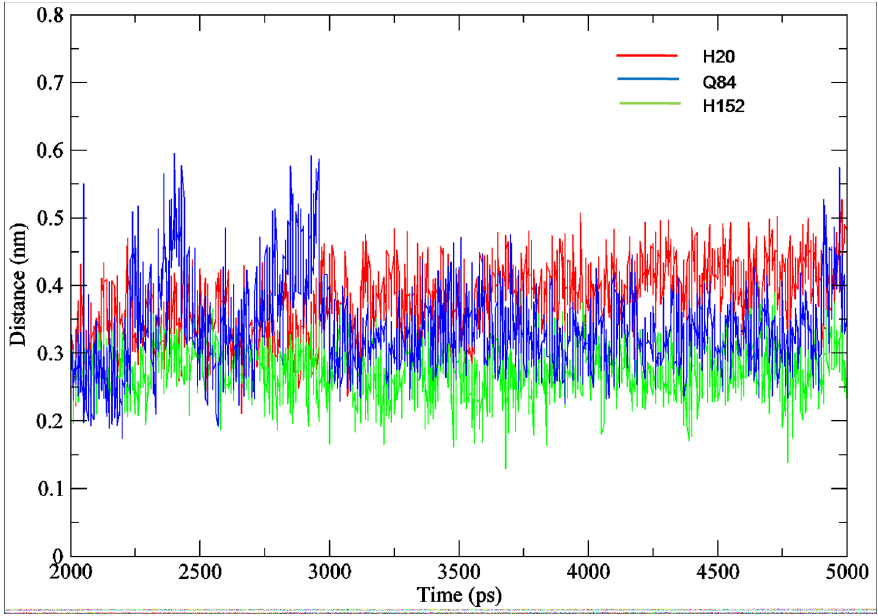
Figure 11. RMSF plot of F.ananassa UGT generated from MDS trajectory. RMSF plot F. ananassa UGT shows negligible fluctuation of catalytic and binding site residues of acceptor and sugar donor